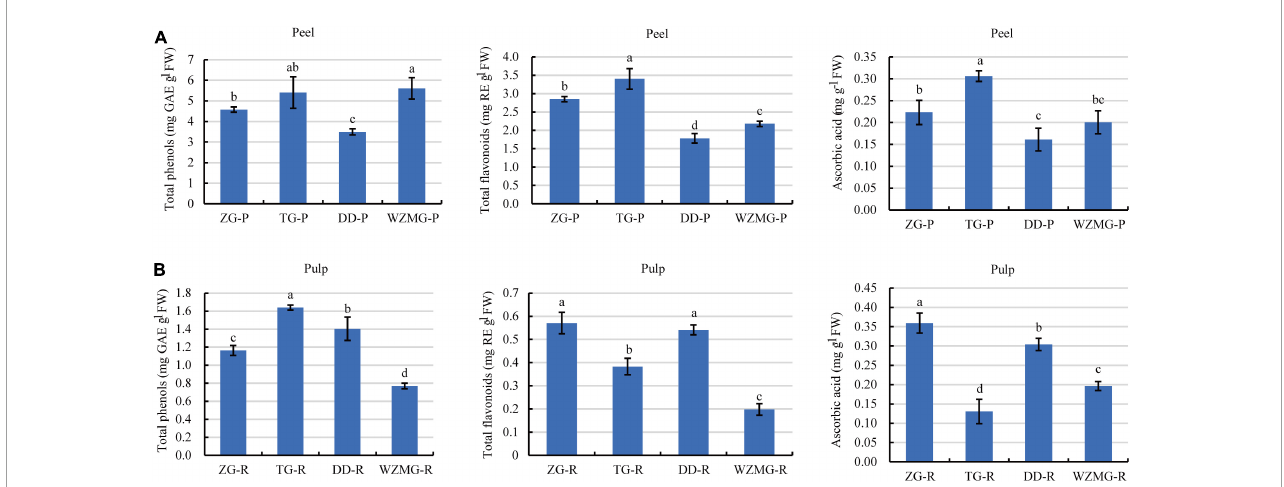
FIGURE5 Comparative analysis of the contents of total phenols, total flavonoids, and ascorbic acid in peel and pulp. (A) Contents of total phenols, total flavonoids, and ascorbic acid in ZG-P, TG-P, DD-P, and WZMG-P. (B) Contents of total phenols, total flavonoids, and ascorbic acid in ZG-R, TG-R, DD-R, and WZMG-R. The different letters in each bar indicate significant differences by Tukey’s test ( P < 0.05). Total phenols and total flavonoids were expressed as gallic acid equivalents (GAE) and rutin equivalents (RE), respectively. FW, fresh weight.